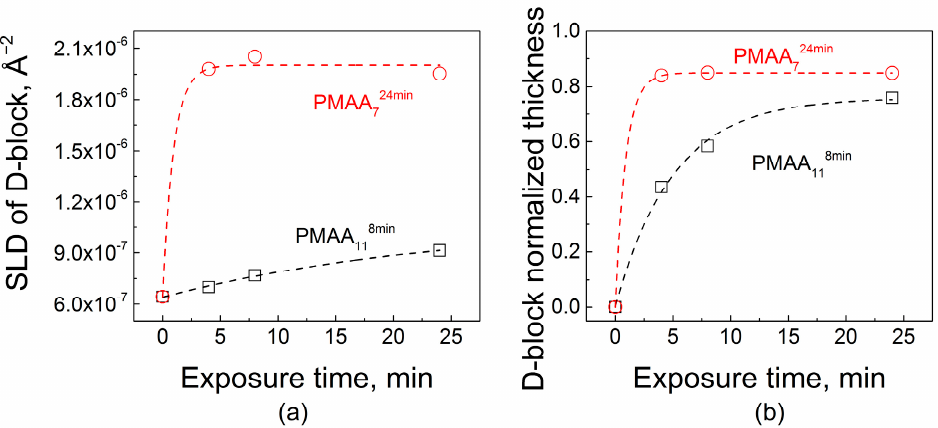
Figure 6. A comparison of the effect on film internal structure of the exposure of hydrogenated PMAA 118min and PMAA 724min films to a 0.2 mg/mL d QPC solution, as illustrated by fitted scattering length density ( a ) and the fitted thicknesses of deuterated block ( b ).